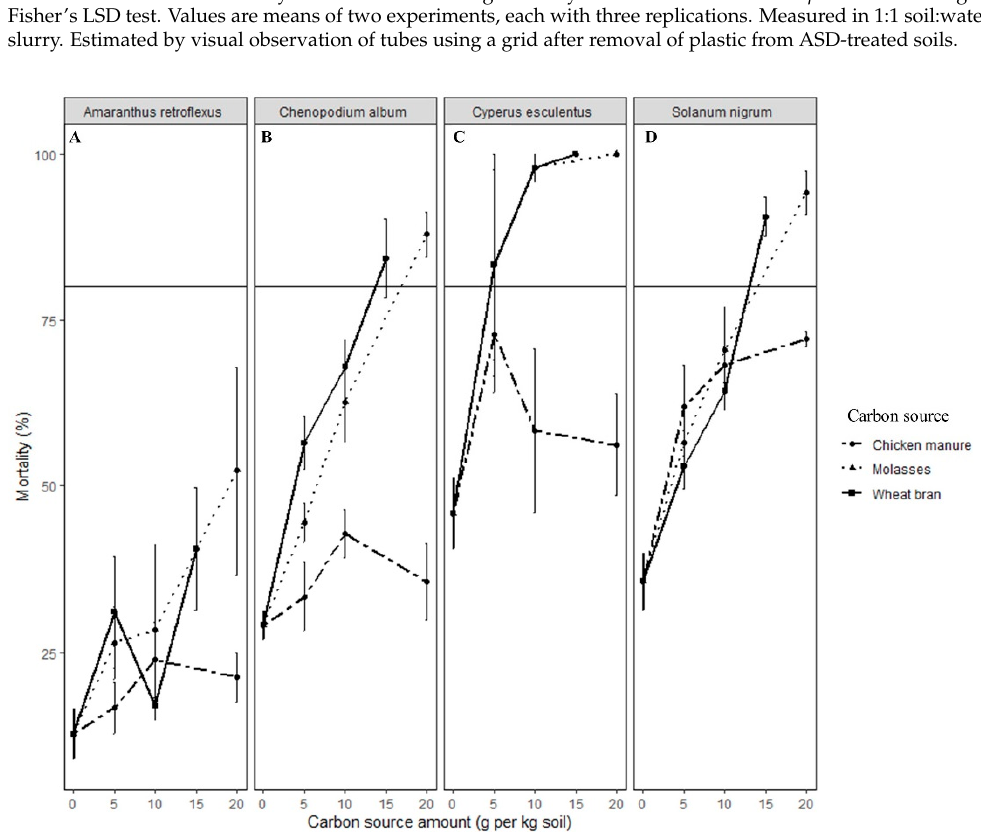
Figure 3. Effect of different rates of anaerobic soil disinfestation (ASD) carbon sources on seed mortality of ( A ). redroot pigweed ( Amaranthus retroflexus ), ( B ). common lambsquarters ( Chenopodium album ), ( C ). yellow nutsedge ( Cyperus esculentus ) and ( D ). black nightshade ( Solanum nigrum ) under growth chamber conditions in 2017. The line indicates 80% mortality and 80% inhibition acceptable for weed suppression. Error bars indicate standard